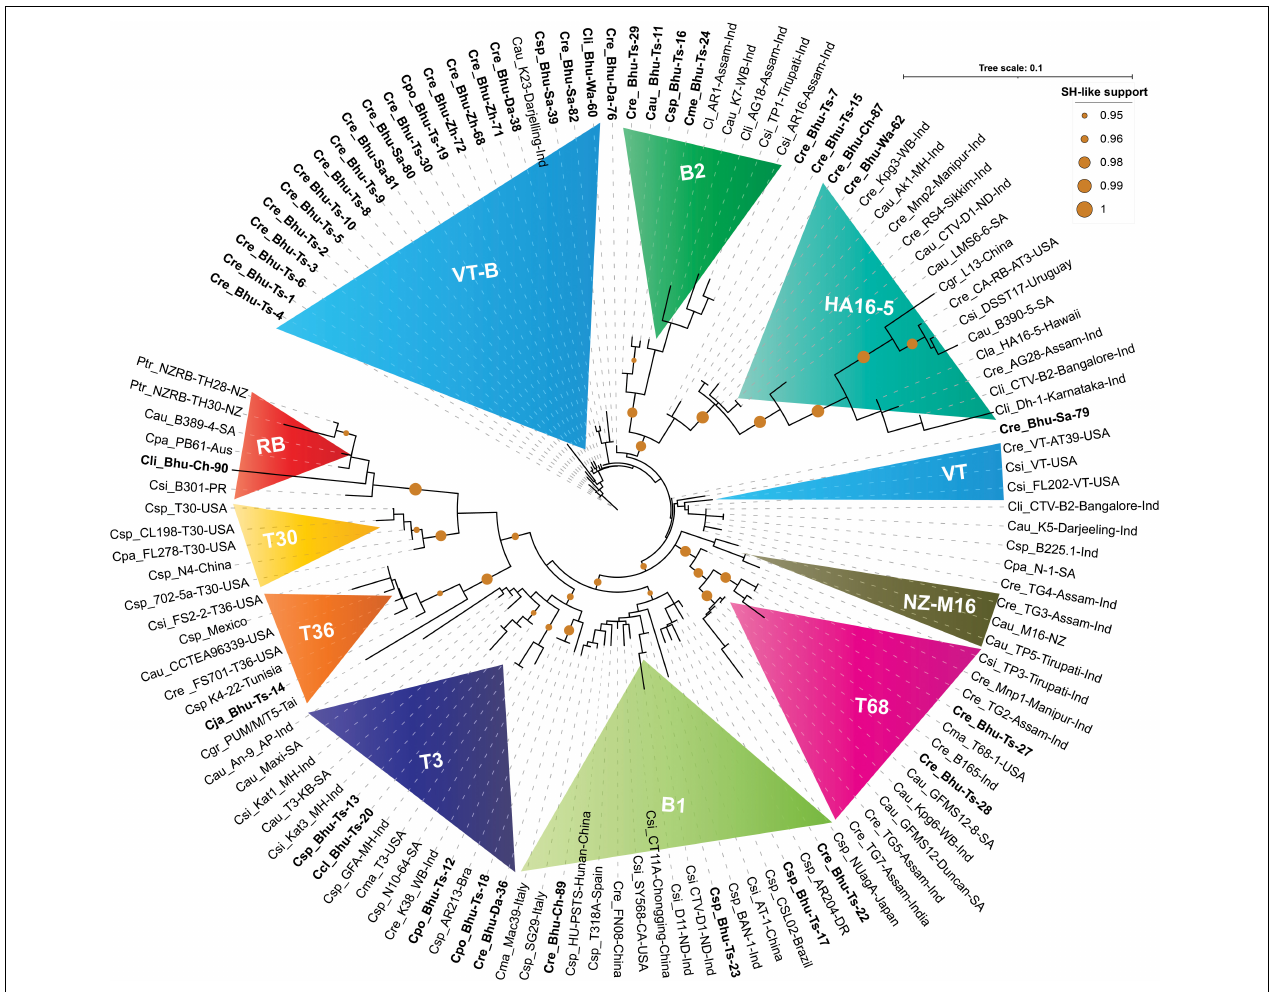
FIGURE 5 | Phylogenetic tree reconstructed using concatenated protein sequences congruent with the nucleotide tree ( Figure 4 ). The maximum likelihood (ML) tree was reconstructed using PHYML3.2.2 (Guindon et al., 2010) with default parameters except for the model parameter that was set to JTT (Jones et al., 1992), and both NNI (nearest-neighbor interchange) and SPR (sub-tree pruning and re-grafting) moves were adopted for better accuracy (Hordijk and Gascuel, 2005). SH-like (Anisimova et al., 2011) support, which is known to outperform bootstrap support (Simmons and Norton, 2014), was used for branch stability. SH-like support of 95% or higher is shown with a mustard color circle. CTV strains were earlier classified under seven (T30, T36, VT, T3, T68, RB and HA16-5) subtypes or variants (Harper, 2013). In contrast, our concatenated protein-based ML tree shows an additional three (B1, B2, and NZ-M16) clades. Clades B1 and B2 are named after the Bhutanese variants. Labeling in the ML tree was made clearer by using the first letter of the genus and two letters of the citrus species, followed by the isolate or genotype name, place, and the country where it was reported. For clarity, Bhutanese isolates are shown in bold font. For a complete list of the GenBank accessions, species name, isolate or variants name, country name, and protein-coding amino acids used to build this tree, refer to Supplementary Excel File 1 , and for the complete list of Bhutanese isolates, refer to Tables 1 , 3